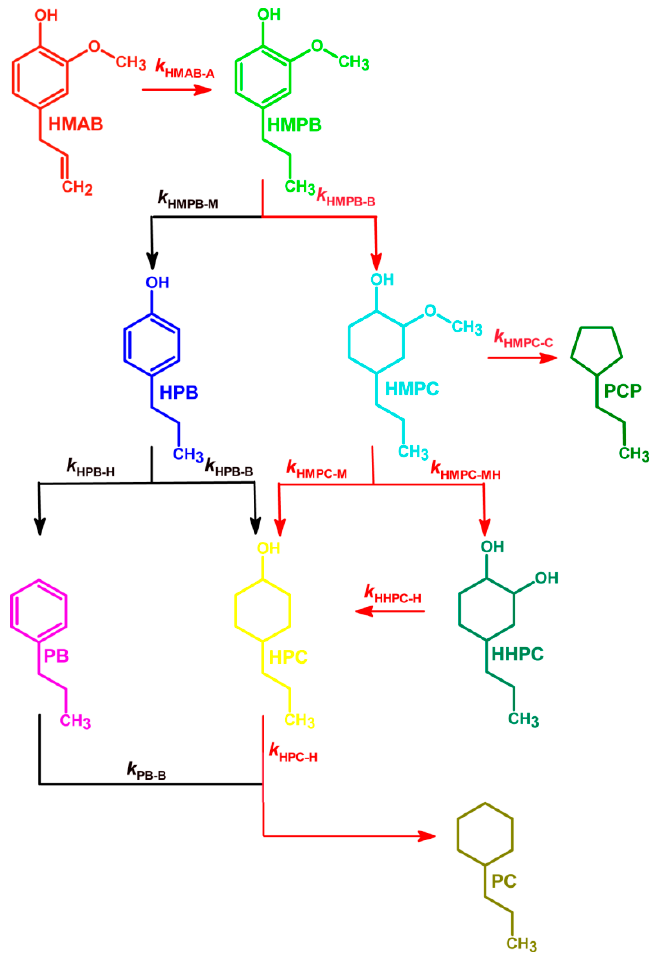
Figure 8. Eugenol reaction network over tested catalysts.